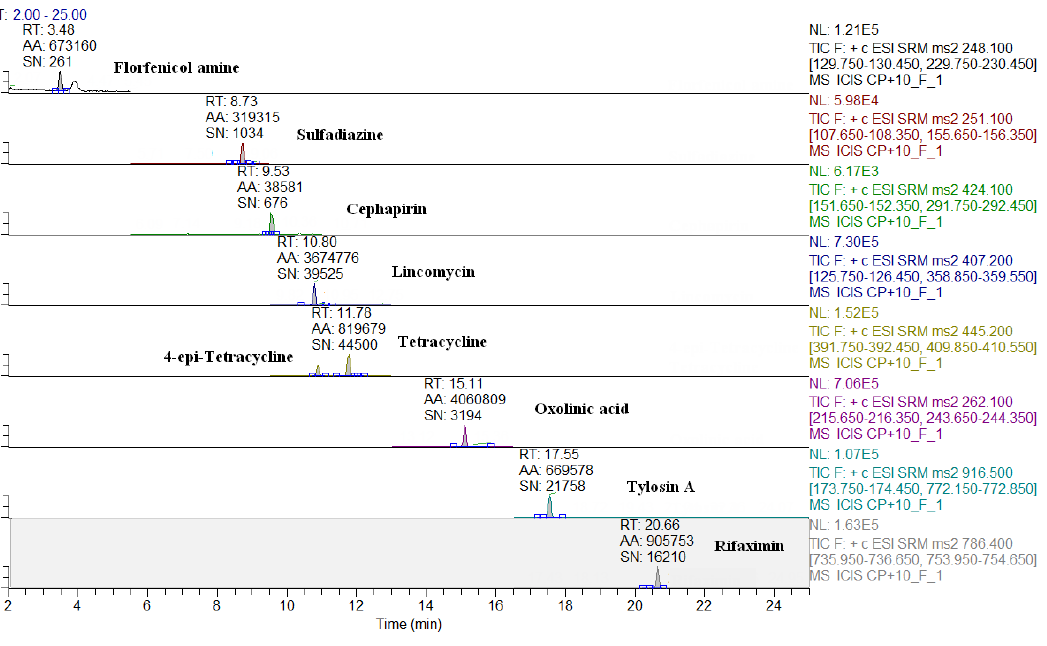
Figure 4. LC-QqQ chromatograms of a spiked bovine milk (10 µg·kg −1 ).